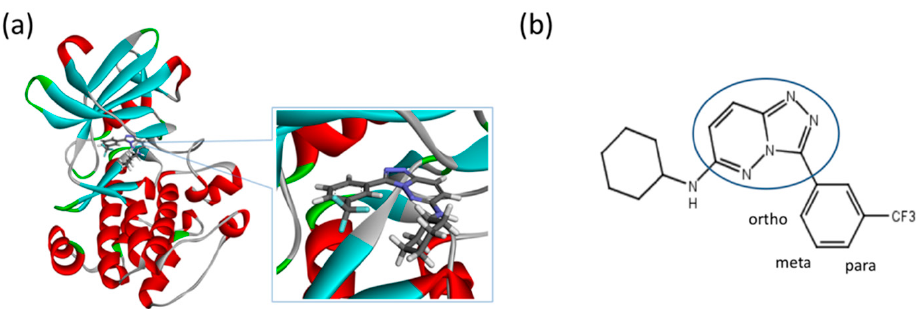
Figure 10. ( a ) A 3D structure of the Pim1 kinase and triazolo pyridazine inhibitor termed as VX2 in the Protein Data Bank (PDB). The PDB code is 3BGQ. We refer to the VX2 as a ligand 1, in this study, for the sake of simplicity of the terminology. ( b ) Chemical structure of the VX2. Circled part of the ligand is termed as triazolo[4,3-b]pyridazine scaffold. This is a common part of all the lig- ands that are applied in this study. (The figure is reprinted from Ref. [16]. Copyright (2017) Ameri- can Chemical